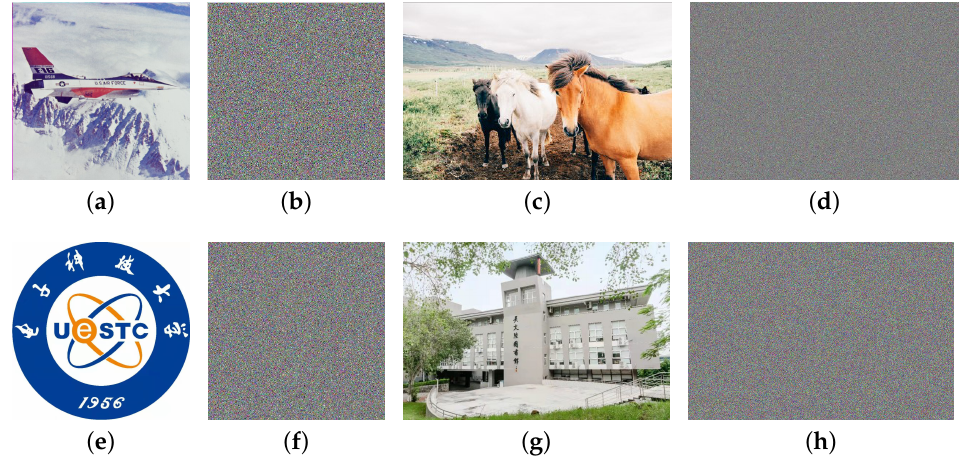
Figure 4. Images before and after encryption: ( a ) 1 # plain image; ( b ) Cipher image of ( a ); ( c ) 2 # plain image; ( d ) Cipher image of ( c ); ( e ) 3 # plain image; ( f ) Cipher image of ( e ); ( g ) 4 # plain image; ( h ) Cipher image of ( g ).